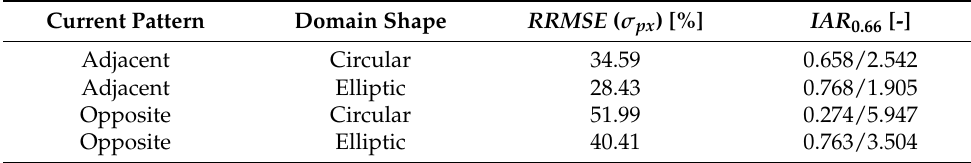
Table 2. The image errors in the individual domain shape